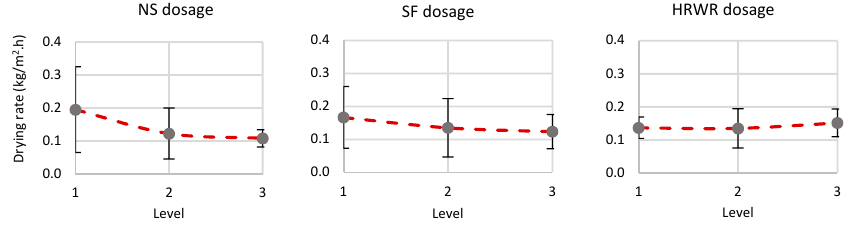
Figure 11. Influence of factors on drying rate values.